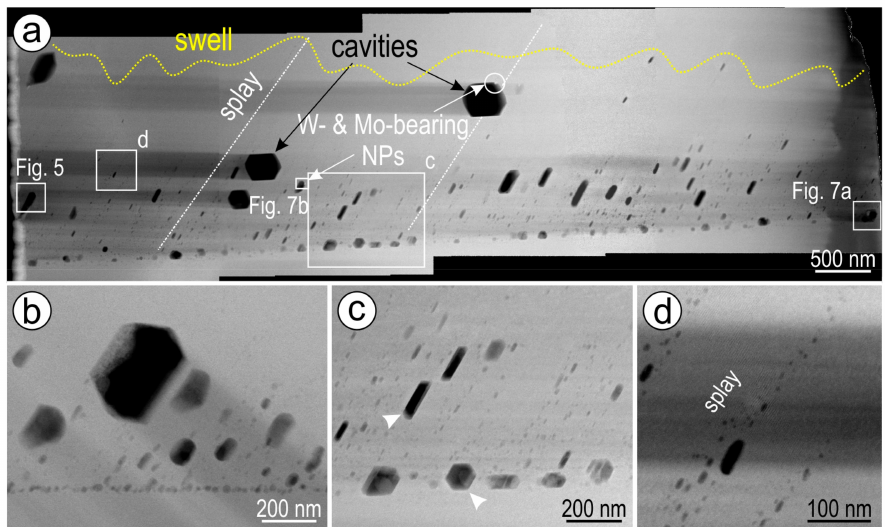
Figure 4. HAADF STEM images showing distribution of inclusions and cavities along trails in hematite. ( a ) Trail representative for the asymmetric distribution of inclusions and cavities (subvertical trail in Figure 3c rotated at 90 ◦ ). Note that the coarsest inclusions are placed within swells (yellow line) on one side of the trail. ( b ) Variation across trail width (several hundred nm; foil #2) showing the finest inclusions ( < 20 nm) as a continuous array on one side expanding into coarsest cavities (~300–400 nm size) on the other side. Swarms of small inclusions are present throughout the area. ( c ) Detail of trail in ( a ) showing a mixture of inclusions and cavities along the array defining the trail on one side. Note hexagonal to tabular morphologies (arrowed) of cavity / inclusions but with swarms of NPs still present throughout the area. ( d ) Detail from ( a ) showing distribution of inclusions / cavities along diagonal splays propagating from one side of the trail.